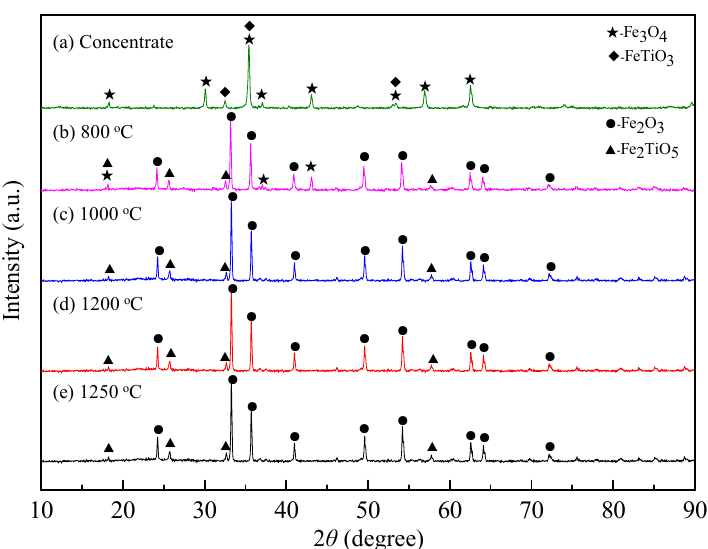
Figure 7. XRD patterns of vanadium-bearing titanomagnetite concentrate before and after roasting (roasting time: 2 h; atmosphere: air): ( a ) Concentrate; ( b ) 800 °C; ( c ) 1000 °C; ( d ) 1200 °C; ( e ) 1250 °C. (roasting time: 2 h; atmosphere: air): ( a ) Concentrate; ( b ) 800 ◦ C; ( c ) 1000 ◦ C; ( d ) 1200 ◦ C; ( e ) 1250 ◦